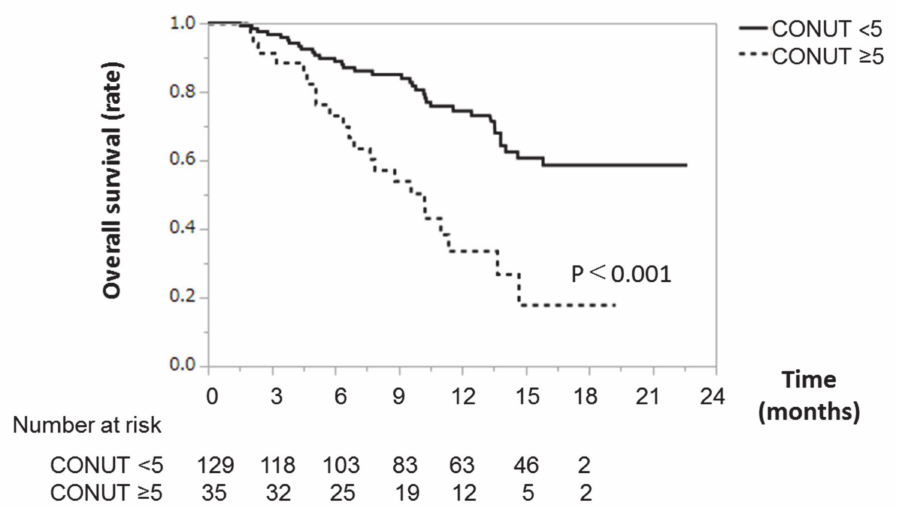
Figure 3. Overall survival time in patients with HCC treated with lenvatinib. Kaplan–Meier survival analysis, showing overall survival time according to CONUT score ( < 5 or ≥ 5) in patients with HCC treated with lenvatinib. The solid line represents the low CONUT group (CONUT score < 5). The dotted line represents the high CONUT group (CONUT score ≥ 5). Abbreviations: HCC, hepatocellular carcinoma; CONUT, Controlling Nutritional